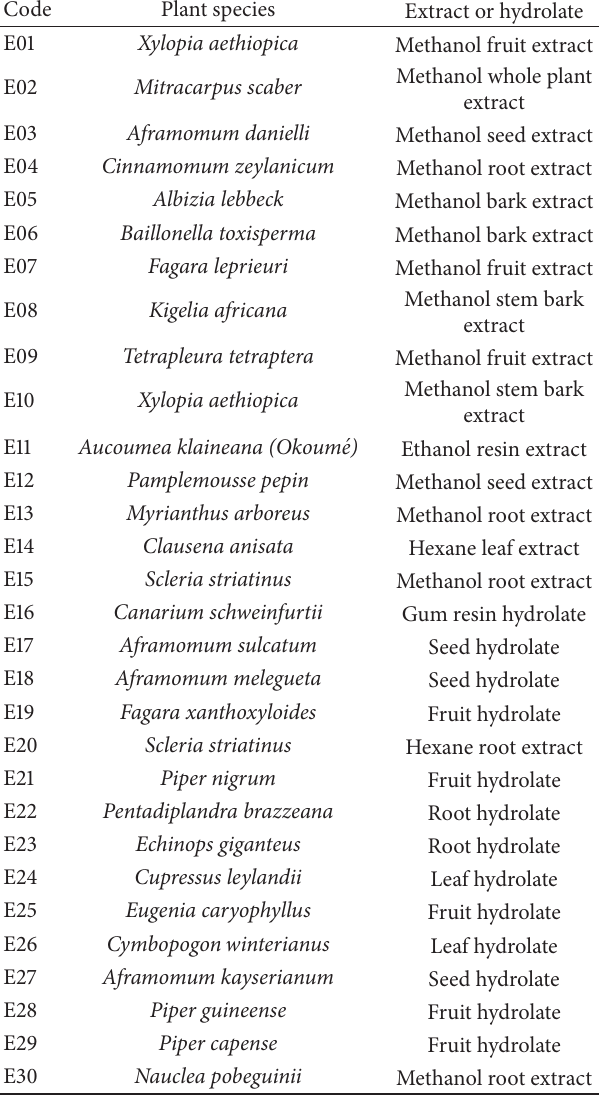
Table 2: Plant extracts or hydrolates and codes: extracts were prepared by air-drying fresh plant material, crushing into powder, and extracting by macerating the powder in hexane, followed by filtration and evaporation. The concentrate was macerated in methanol, filtered, and evaporated and the resulting concentrated crude extracts were coded as shown and stored at 4 ∘ C until required for use. Hydrolates were obtained by separating the aqueous water from essential oils after steam distillation in the course of extracting essential